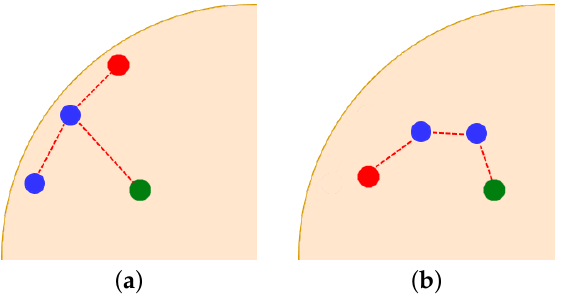
Figure 3. D P selection procedure (green node— D H m devices located on the boundary, ( b ) D P